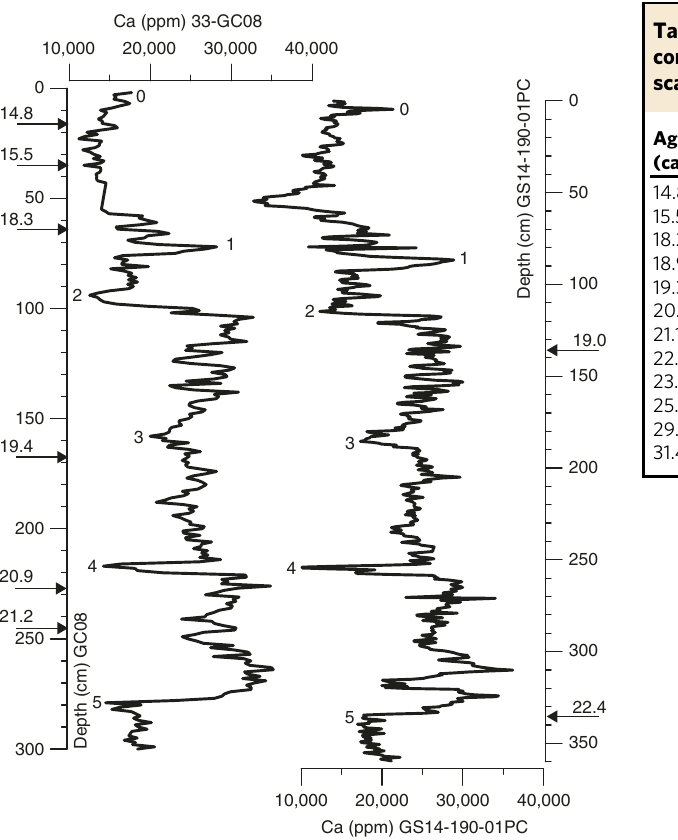
Fig. 3 X-ray fl uorescence records of calcium (Ca) concentrations (ppm) in 33-GC08 and GS14-190-01PC against respective core depths (cm). AMS 14 C (calibrated) datings for each core are shown (see Table 1). Numbers 1 – 5 indicate correlation tie points (Table 2) between the cores to establish a common depth scale